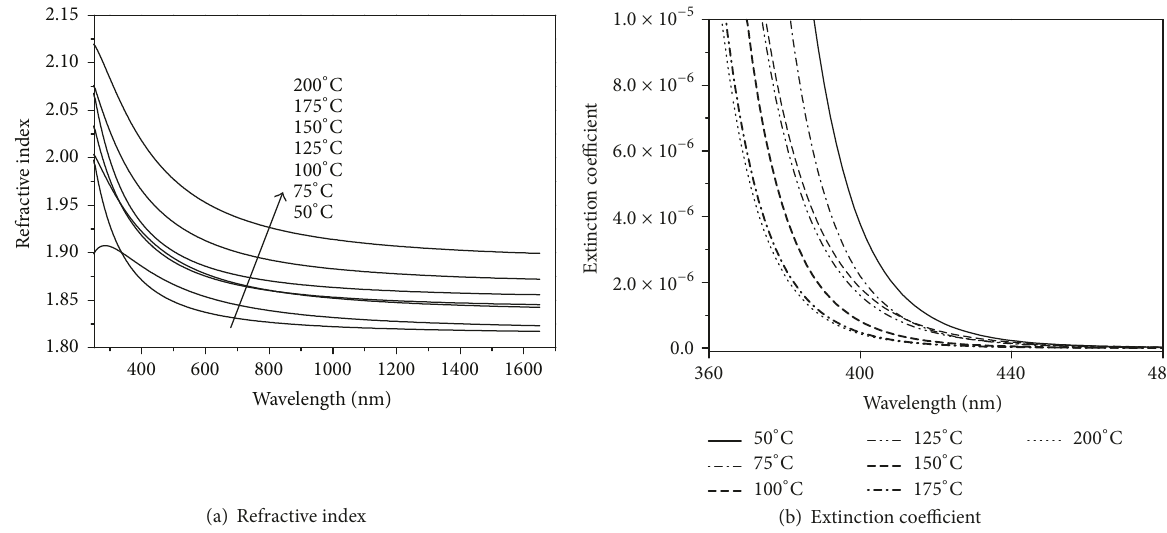
Figure 3: Refractive index (a) and extinction coefficient (b) of samples.